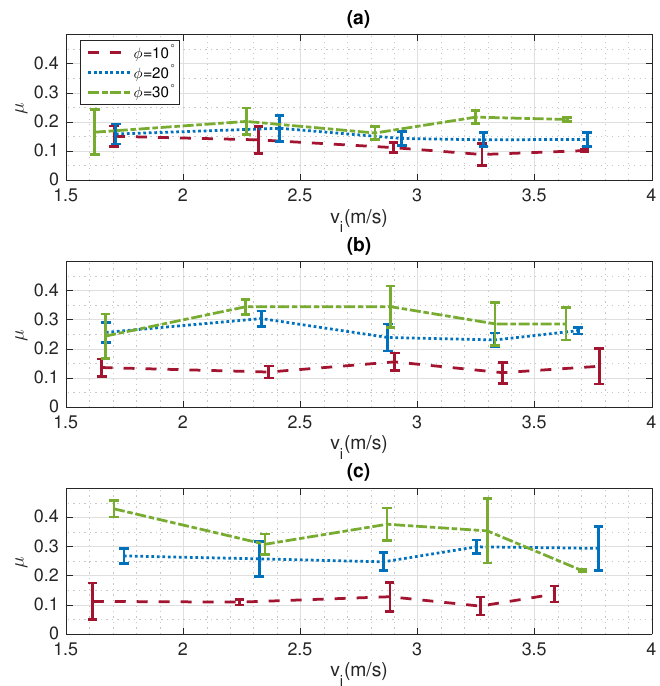
Figure 5. Mean effective coefficient of friction for different impact surfaces ( a ) steel, ( b ) concrete and ( c ) asphalt. Error bars indicate the standard deviations.